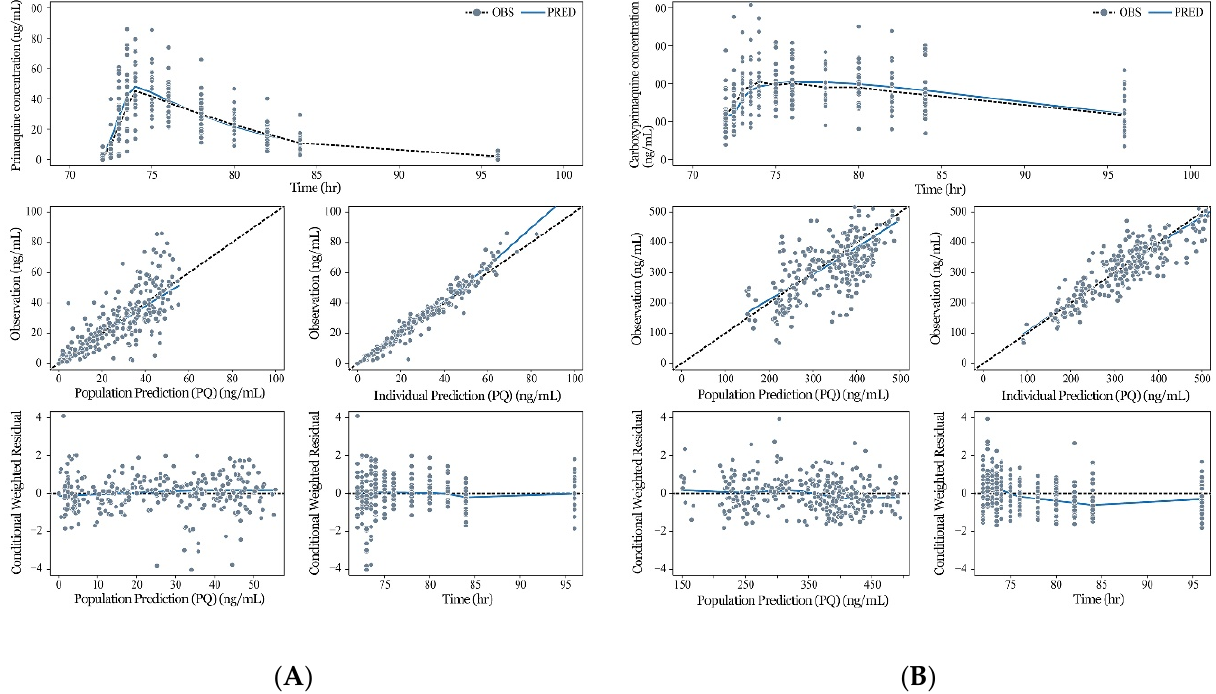
Figure 3. Goodness-of-fit plots for the final PK model for primaquine (PQ) and carboxyprimaquine (CPQ). ( A ) Goodness-of-fit plots for PQ; TOP: Observed concentrations (dots), their smooth (dotted line), and population predictions (solid line) vs time for PQ; MIDDLE: Observed concentrations vs population predictions (left) and vs individual predictions (right) for PQ (solid line: smooth; dashed line: line of identity); BOTTOM: Conditional weighted residual vs population prediction (left) and vs time (right) for PQ (solid line: smooth; dashed line: line of zero residual); ( B ) Goodness-of-fit plots for CPQ; TOP: Observed concentrations (dots), their smooth (dotted line), and population predictions (solid line) vs time for CPQ, MIDDLE: Observed concentrations vs population predictions (left) and vs individual predictions (right) for CPQ (solid line: smooth; dashed line: line of identity); BOTTOM: Conditional weighted residual vs population prediction (left) and vs time (right) for CPQ (solid line: smooth; dashed line: line of zero residual). OBS, observation; PRED,